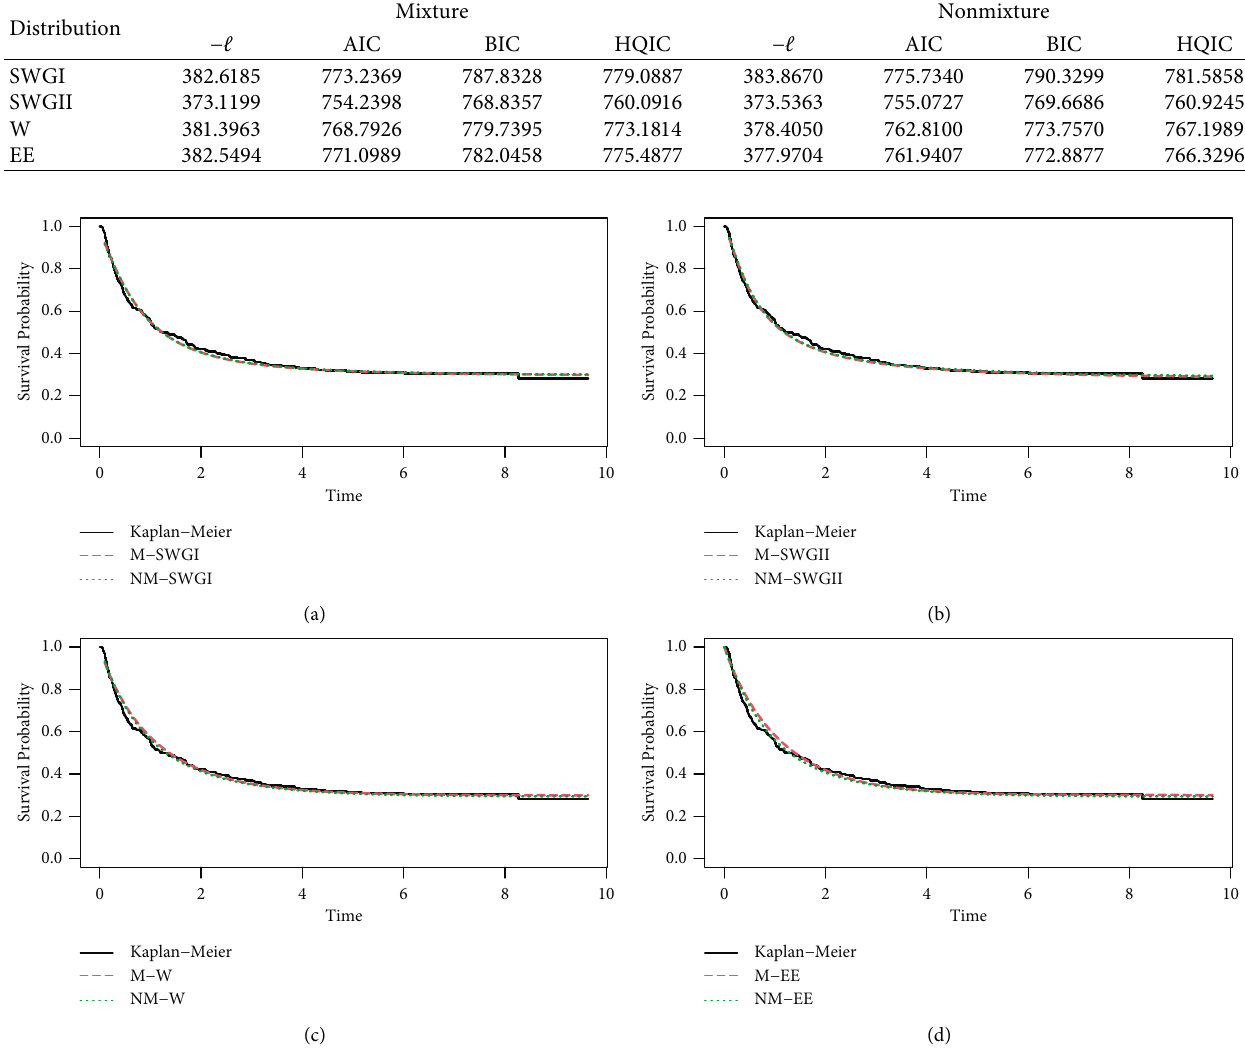
Figure 5: Fitted survival curves of melanoma